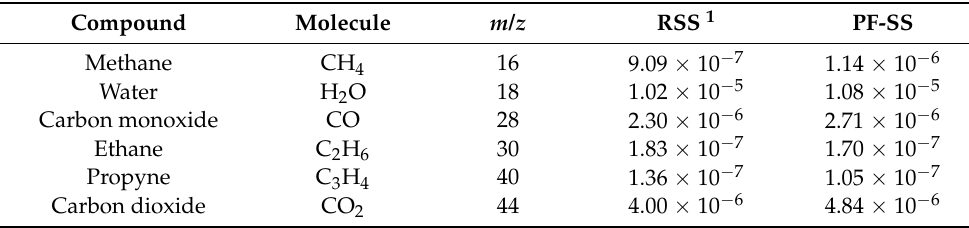
Table 2. MS peak areas of the main C/H/O-containing permanent gases during the pyrolysis of the sludge